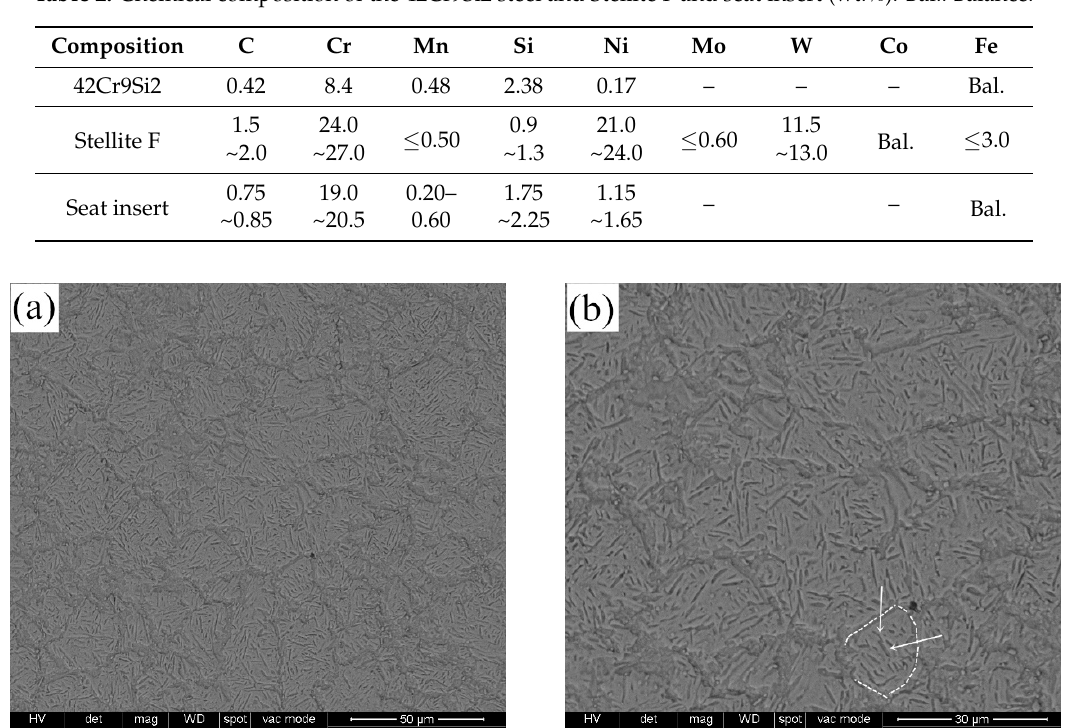
Table 2. Chemical composition of the 42Cr9Si2 steel and Stellite F and seat insert (wt.%). Bal.: Balance.